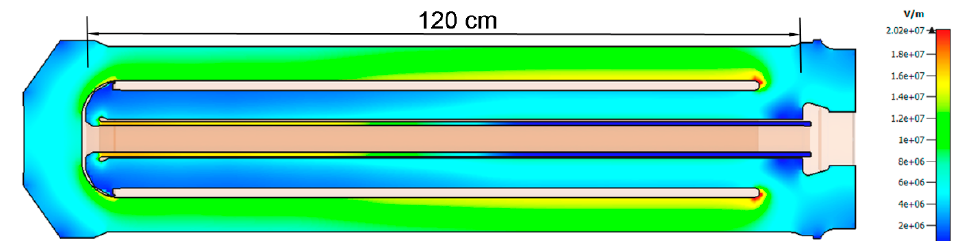
Figure 7. Simulation results on field distribution in real TWFL at discharge point of 10 ns.